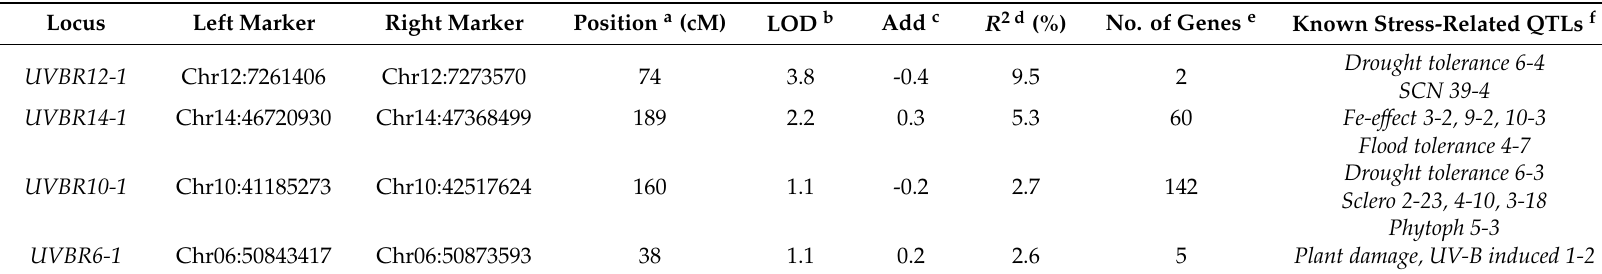
Table 1. Quantitative trait loci (QTLs) for UV-B stress resistance identified by inclusive composite interval mapping in 176 RILs derived from Cheongja 3 × Buseok. Locus Left Marker Right Marker Position a (cM) LOD b Add c R 2 d (%) No. of Genes e Known Stress-Related QTLs